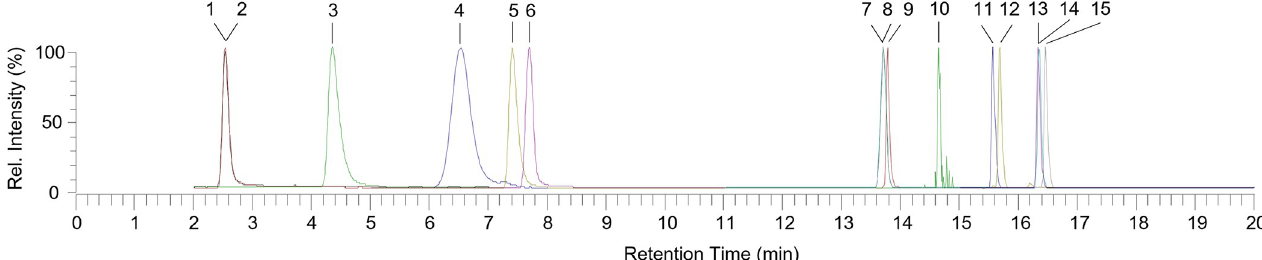
Fig 1. Chromatogram of B vitamins standards and internal standards at (500 μ g/L). Peak identification: 1—IS-B3 (Stable isotope labelled internal standard), 2—B3 (Niacin), 3—B1 (Thiamine), 4 - B6-5P (Pyridoxal 5-phosphate), 5—B6 (Pyridoxine), 6 - B3-AM (Niacinamide), 7—IS-B5 (Stable isotope labelled internal standard), 8—B5 (Pantothenic acid), 9 - B6-4PA (4-Pyridoxic acid), 10 - B9-THF (Tetrahydrofolic acid), 11—B12 (Cyanocobalamine), 12—B9 (Folic acid), 13—IS-B7 (Stable isotope labelled internal standard), 14—B7 (Biotin), 15—B2 (Riboflavin).